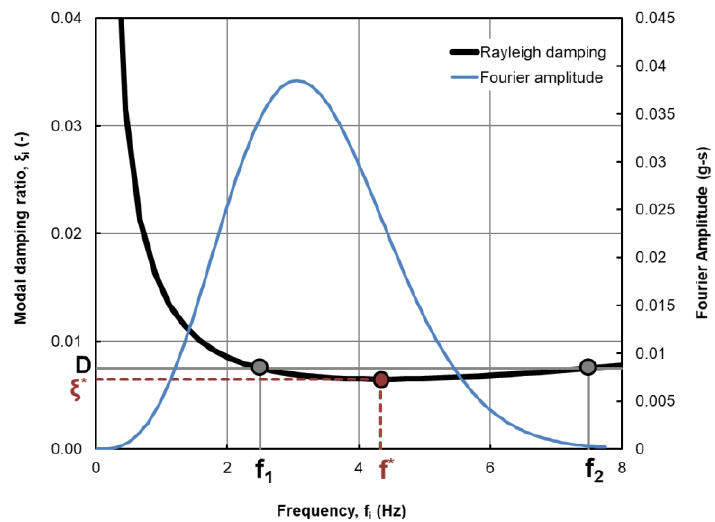
Figure 3. Rayleigh damping curve (black line) over imposed to the Fourier amplitude spectrum with the identification of the single control frequency, f*, the two control frequencies, f 1, and f 2 , the minimum modal damping ratio, ξ*, and the small strain damping ratio, D.